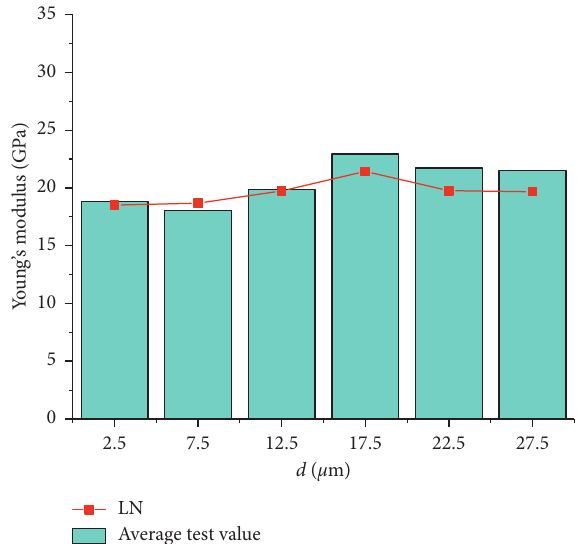
Figure 7: Comparison among all test and calculated results.